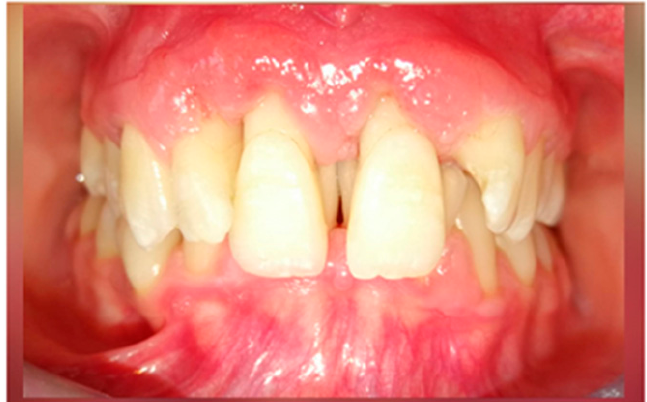
Figure 5. Clinical aspect three weeks after the initial visit and periodontal treatment.